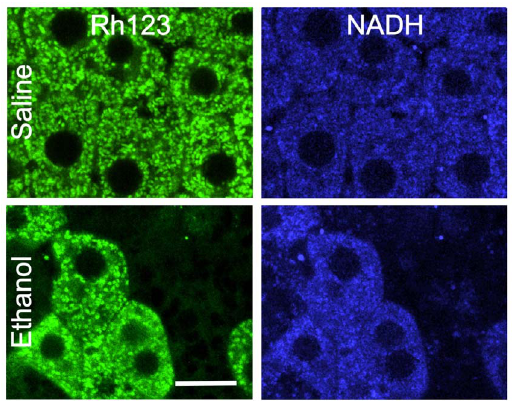
Figure 4. Ethanol-induced mitochondrial depolarization is associated with oxidation of mitochondrial NAD(P)H. Mice were gavaged with saline or ethanol (6 g/kg). Mitochondrial polarization was detected by Rh123 fluorescence (left column), and mitochondrial NAD(P)H (right column) was detected by autofluorescence after 2 h. Representative images of 4 mice per group are shown. Bar is 10 m